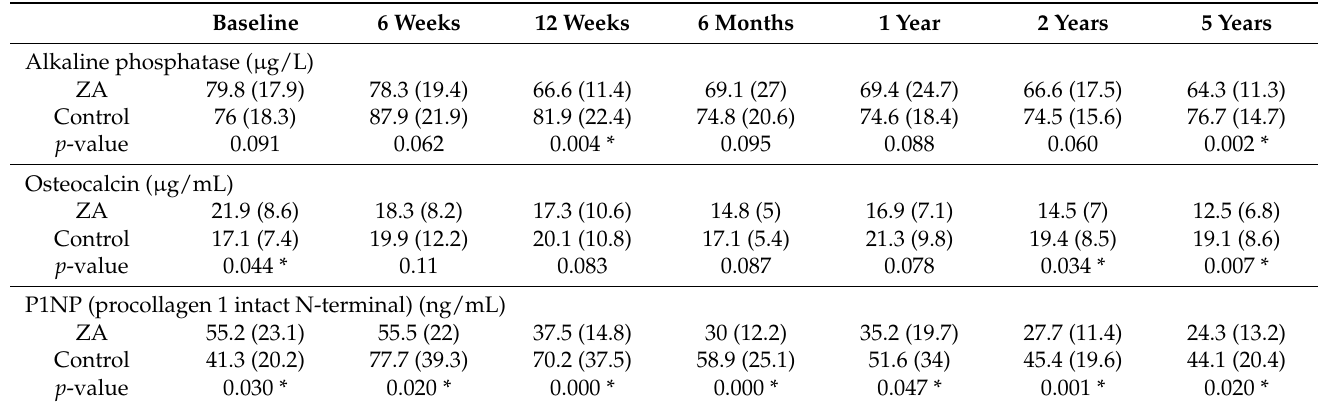
Table 1. Comparison of bone turnover markers in ZA ( n = 25) and control ( n = 24).